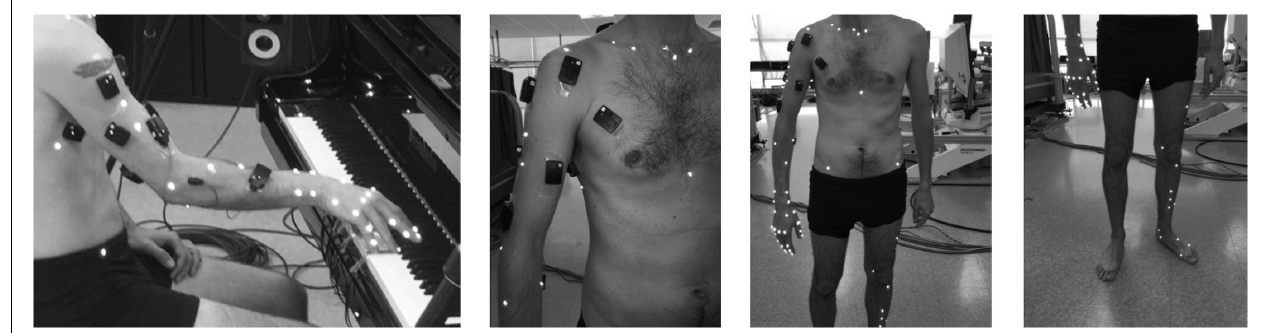
FIGURE 1 | Location of markers for motion capture (participants also wore surface electromyography sensors, but these data are not discussed here).